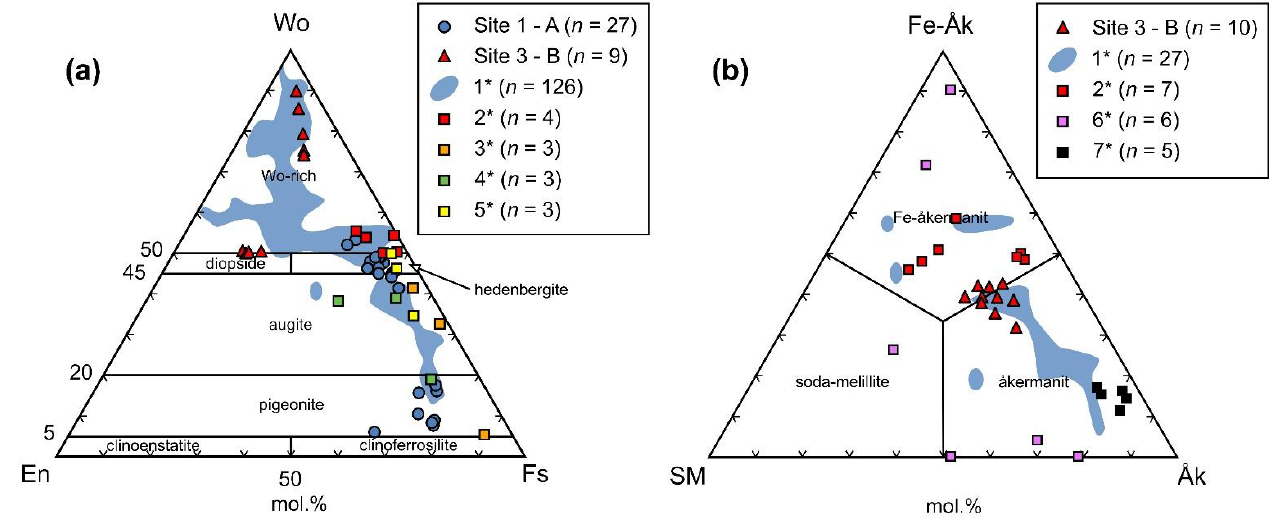
Figure 6. Compositions of pyroxene projected in the ternary system Wo-En-Fs ( a ) (according to [45]) and melilites plotted in FeÅk-SM-Åk ternary diagram ( b ). SM—soda melilite, comparative data: 1* — Lower Silesia (Poland; [10]), 2* —Příbram (Czech Republic; [44]), 3*— Kutná Hora (Czech Re- public; [6]), 4* —Příbram (Czech Republic; [8]), 5*— Massa Maritima (Italy; [5]), 6* — Prague (Czech Republic; [46]), 7* — Silesian-Cracovian region (Poland; [11]). Wollastonite is exclusive in Type B slags (assemblage II), where is present in the form of euhedral to subhedral short columns and laths. The overall small size of crystals (<10 µ m) does not allow to determine chemical zonation. The wollastonite is relatively pure (2.82–2.95 apfu Ca) with only minor contents of FeO (0.59–0.77 wt.%), Al 2 O 3 (0.62 wt.%), BaO (0.39 wt.%), MnO (0.23 wt.%) and TiO 2 (0.21 wt.%), which could be partially addressed by the small size of the analysed